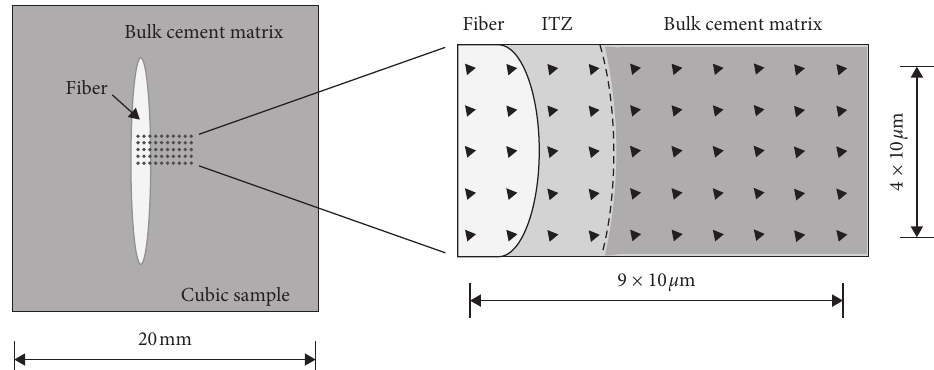
Figure 2: Test point distribution for nanoindentation tests.